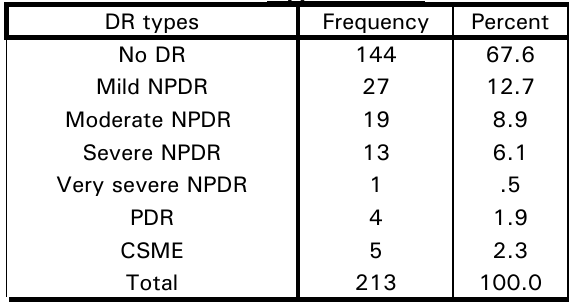
Table 1: Types of DR